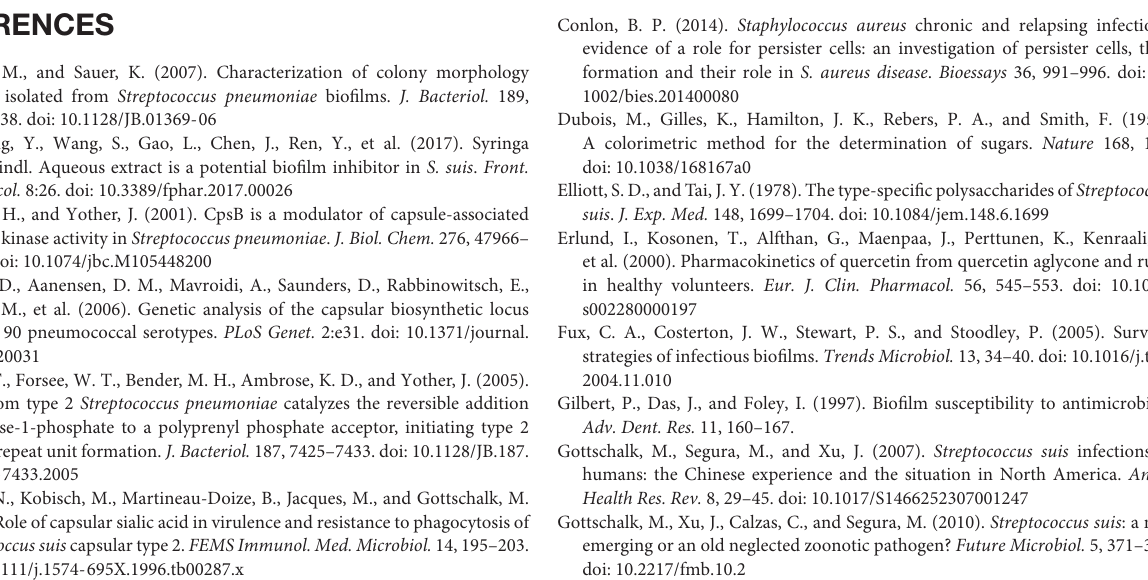
FIGURE S1–S21 | Effect of rutin on cps gene